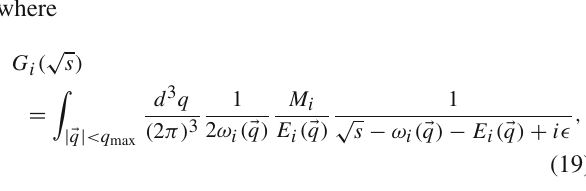
Fig. 5 Feynman diagram for the (cid:2) ∗ → ¯ K π(cid:3) three body decay